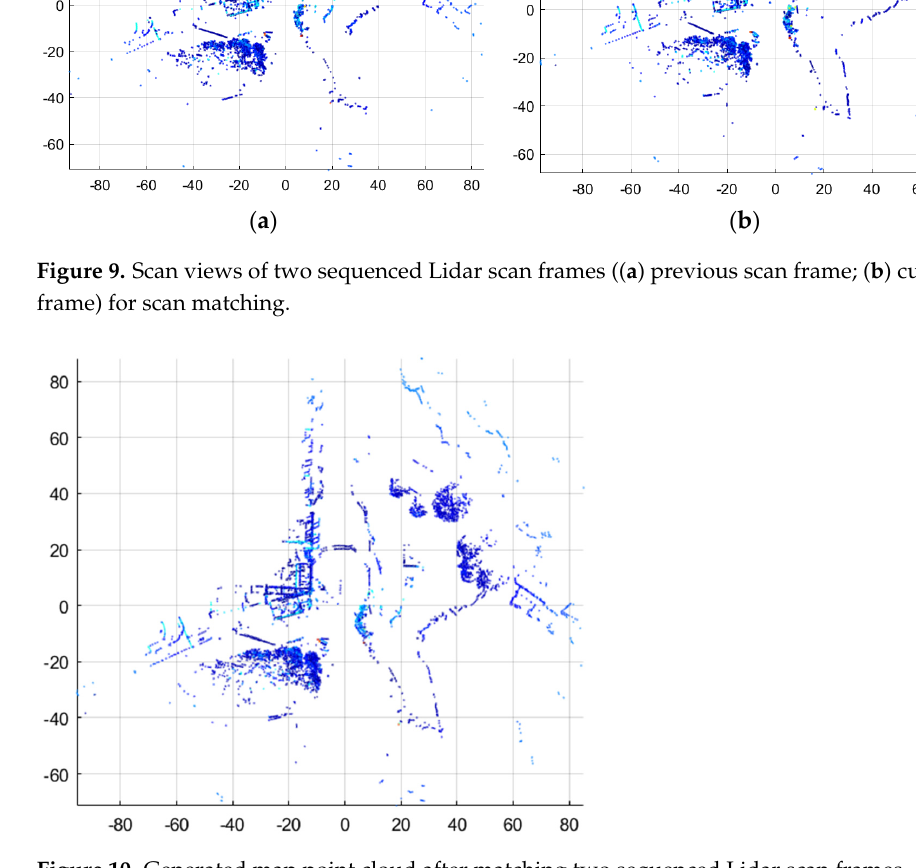
Figure 10. Generated map point cloud after matching two sequenced Lidar scan frames. By conducting Lidar odometry sequentially with all the available Lidar scans, the newly matched point cloud can be merged with the previously generated point cloud maps, and the accumulated map of the whole trajectory can be obtained and georefer- enced, as shown in Figure 11.